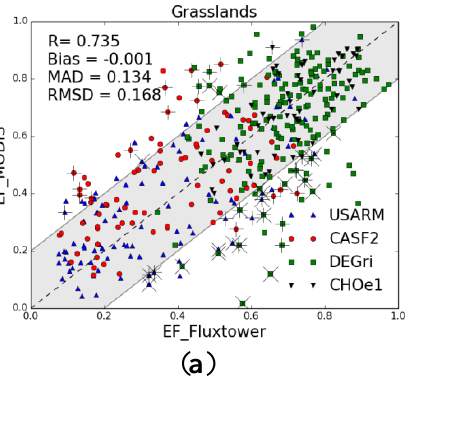
Figure 4. Comparisons of daytime estimated and observed EF at FLUXNET sites for different biome types: ( a ) Grasslands; ( b ) Croplands; ( c ) Cropland/Natural Vegetation Mosaic; ( d ) Closed Shrublands; ( e ) Deciduous Broadleaf Forest; ( f ) Mixed Forest; ( g ) Savannas. Dashed line is the 1:1 line. Grey area represents that the